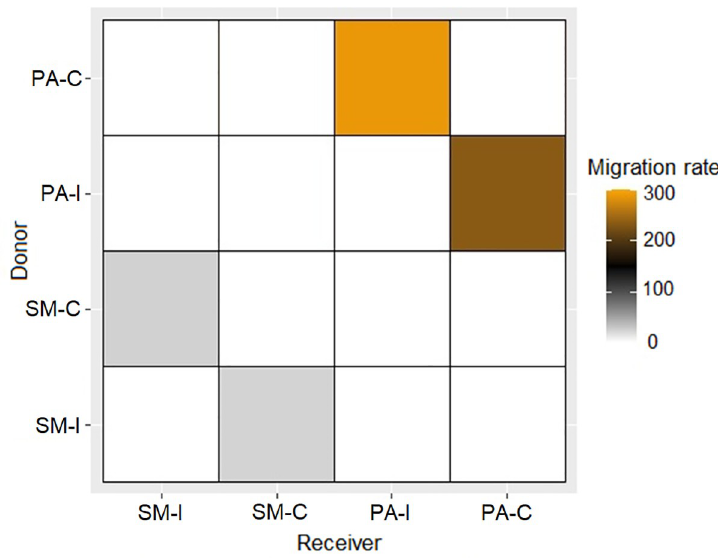
Fig 4. Graphical heat map of migration rates between populations. SM-I: Santa Marı´a Island, SM-C: Santa Marı´a continent, PA-I: Pan de Azu´car Island, PA-C: Pan de Azu´car continent.